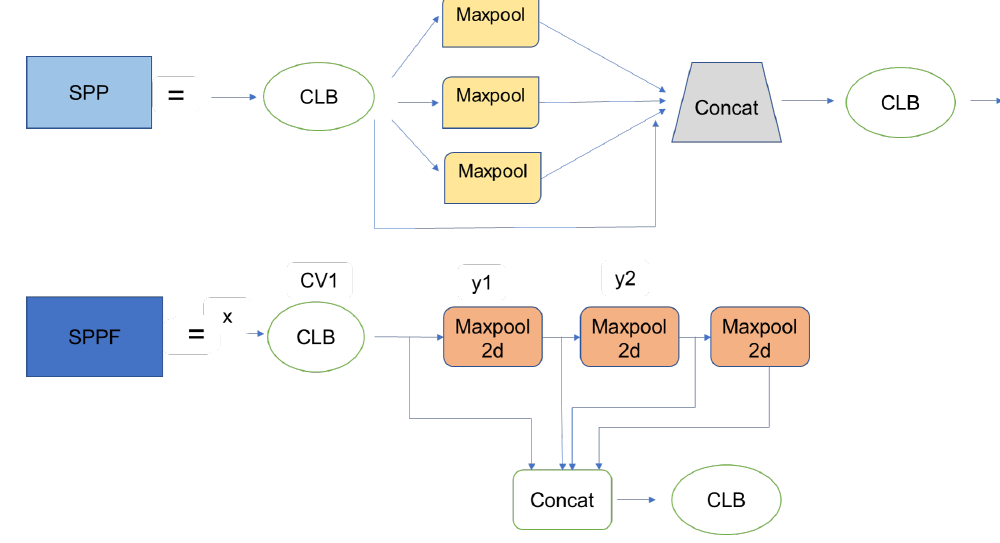
Figure 11. Comparison of the architecture of SPP and SPPF